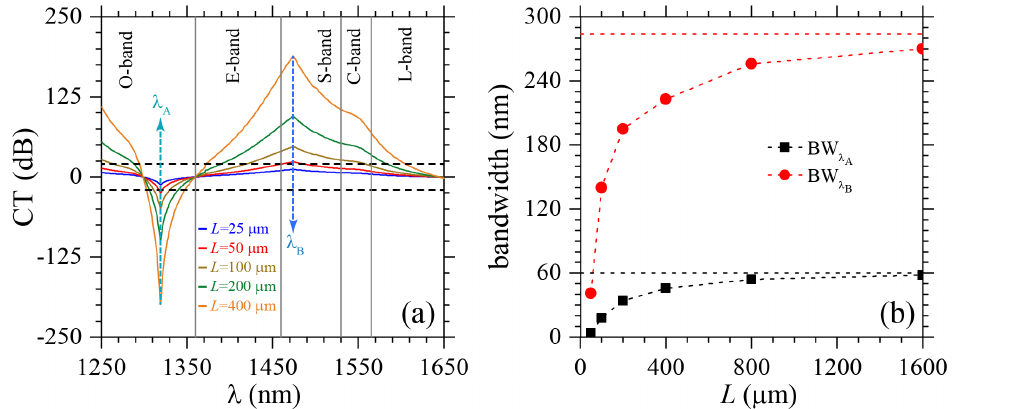
Figure 4. ( a ) Cross-talk parameter as function of the wavelength. Results are presented in the wavelength range from 1250 nm to 1625 nm, i.e., from the telecommunications O-band to the L-band, for different fiber lengths L . The horizontal dashed lines are used to indicate the threshold values of the cross-talk (CT) parameter, i.e., ± 20 dB CT, for polarization filtering applications. The vertical dashed arrows show the resonant wavelengths (phase-matching condition), where maximum and minimum peaks of CT are observed for all L values. Solid vertical lines help visually identify different telecommunication bands. ( b ) The bandwidths for polarization filtering, at wavelengths λ A (BW A ) and λ B (BW B ), is presented as function of the fiber length. BW A and BW B asymptotically approach 60 nm and 284 nm, respectively, as indicated by horizontal dashed